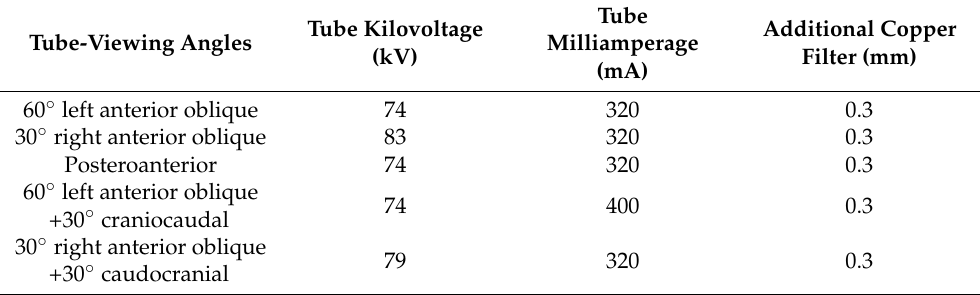
Table 1. X-ray exposure setup used in our study.